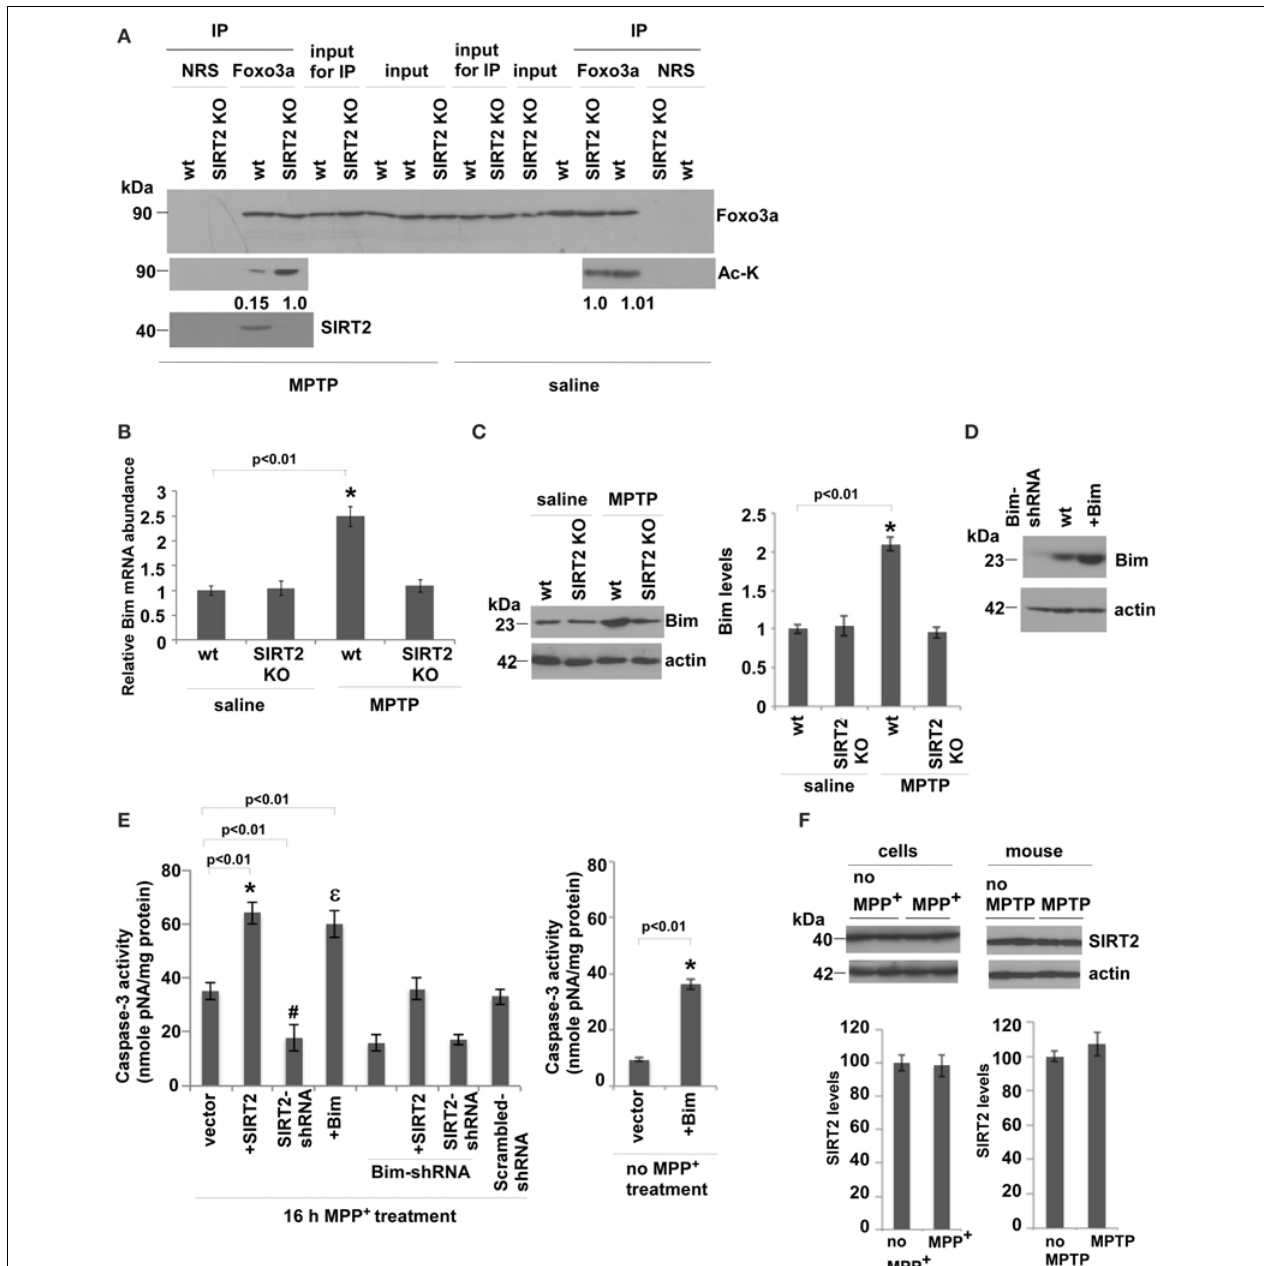
FIGURE 3 | SIRT2 deacetylates Foxo3a, increases Bim levels and leads to apoptosis in MPTP-treated mouse brains. (A) SIRT2 deacetylates Foxo3a in MPTP-injected mouse brains. The lysates from wt or SIRT2 KO mouse brains were immunoprecipitated with Foxo3a antibody or NRS (Normal Rabbit Serum) and blotted with anti-Foxo3a or anti-acetylated lysine (Ac-K) antibodies in saline or MPTP-injected mouse brains. Quantification of acetylated bands was carried out by densitometry using the NIH ImageJ program and is shown below the gel. Representative blots are shown. (B) Bim RNA levels quantified from whole brains of mice by qPCR. n = 6 for each indicated group. Statistical analyses were carried out using Two-Way ANOVA. ∗ p < 0 . 01, wt-MPTP vs. wt-saline. (C) Western blotting of Bim protein extracted from whole brains of saline or MPTP-treated wt or SIRT2 KO mouse brains. n = 6 for each group. Actin serves as loading control. Representative immunoblot is shown. Quantification of the relative Bim protein levels is shown on the